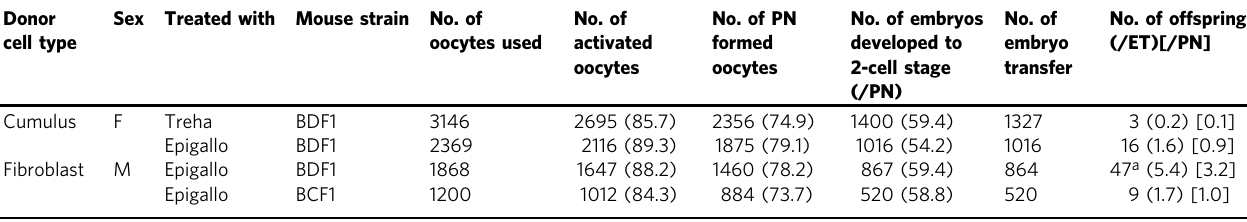
Table 2 Production of cloned mice from freeze-dried somatic cell via ntES cells. Donor Sex Treated with Mouse strain No. of cell type